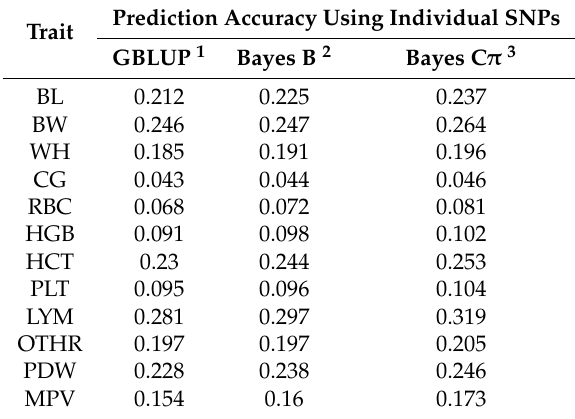
Table 4. Statistical summary of the accuracy of prediction of the 12 target traits. Prediction Accuracy Using Individual SNPs Trait